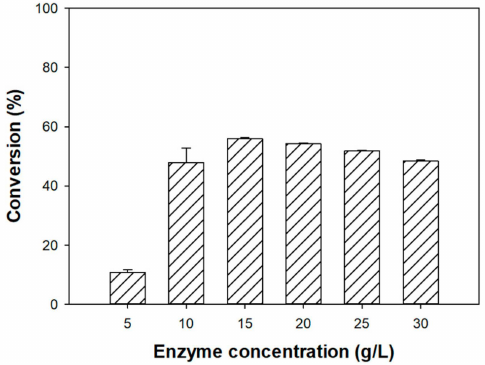
Figure 2. E ff ect of Novozym 435 concentration on the formation of phenethyl formate. The conversion yield (%) was calculated by GC